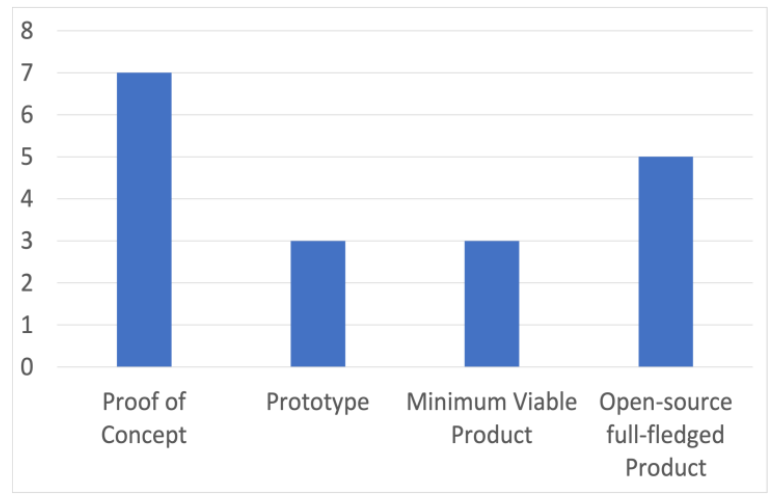
Figure 5. Number of studies in each